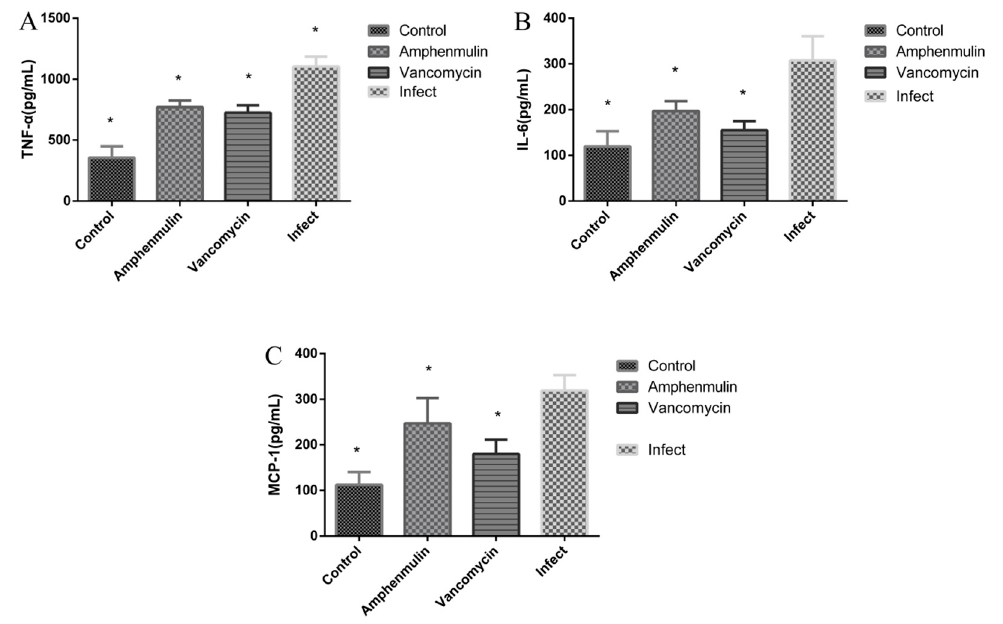
Figure 7. Amphenmulin modulates MRSA mediated-induction of TNF- α ( A ), IL-6 ( B ), and MCP-1 ( C ). * 0.01 < p < 0.05 vs Infect group.